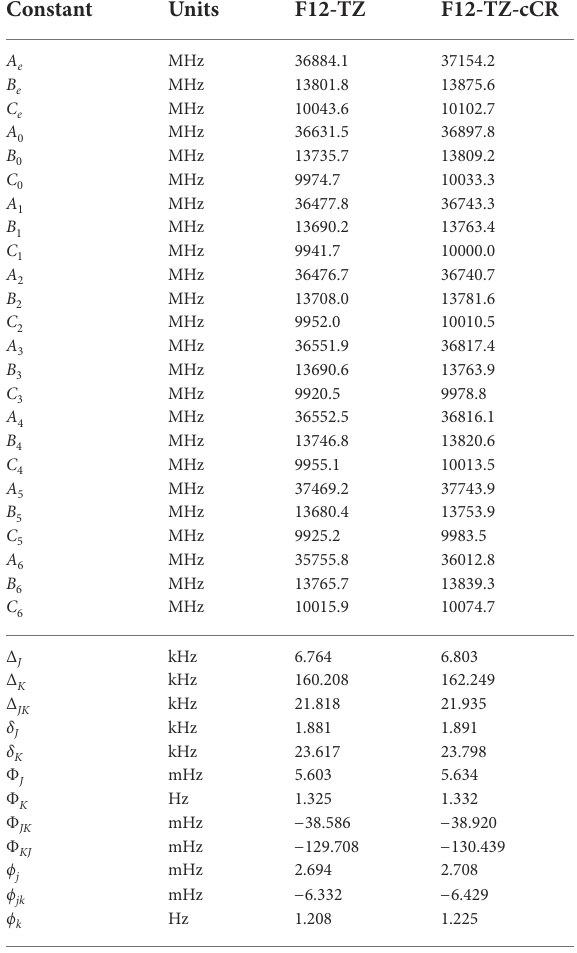
TABLE 2 Equilibrium ( e ), vibrationally-averaged ( 0 ), and singly-vibrationally excited ( n >0 ) principal rotational constants, quartic ( Δ / δ ) and sextic ( Φ / ϕ ) distortion constants, principal rotational constants, and quartic for r -C 4